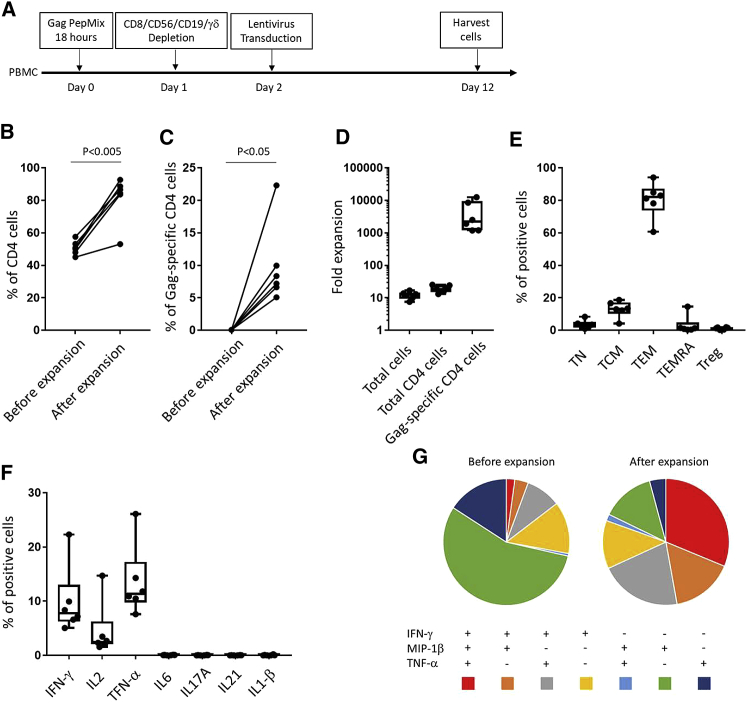
Expansion of HIV Gag-Specific CD4 T Cells by Peptide Stimulation and CD8/CD56/CD19/γδ Depletion(A) Experimental design to expand HIV Gag-specific T cells. (B and C) The percentage of CD4 (B) and Gag-specific CD4 (C) T cells before and after expansion. Paired T Tests were performed. All tests were two-tailed and P values of P<0.05 were considered significant. (D) Fold expansion of total cells, total CD4 T cells, and HIV Gag-specific CD4 T cells. Boxplots show all points (min to max) and mean. (E) The percentage of different T subsets among expanded cells. Boxplots show all points (min to max) and mean. (F) The percentage of CD4 T cells producing different cytokines among expanded cells after restimulation with Gag peptides. Boxplots show all points (min to max) and mean. (G) The pie charts represent the average frequencies of active, cytokine-producing cells, producing every possible combination of the three cytokines analyzed (n = 8; see also Figure S6).